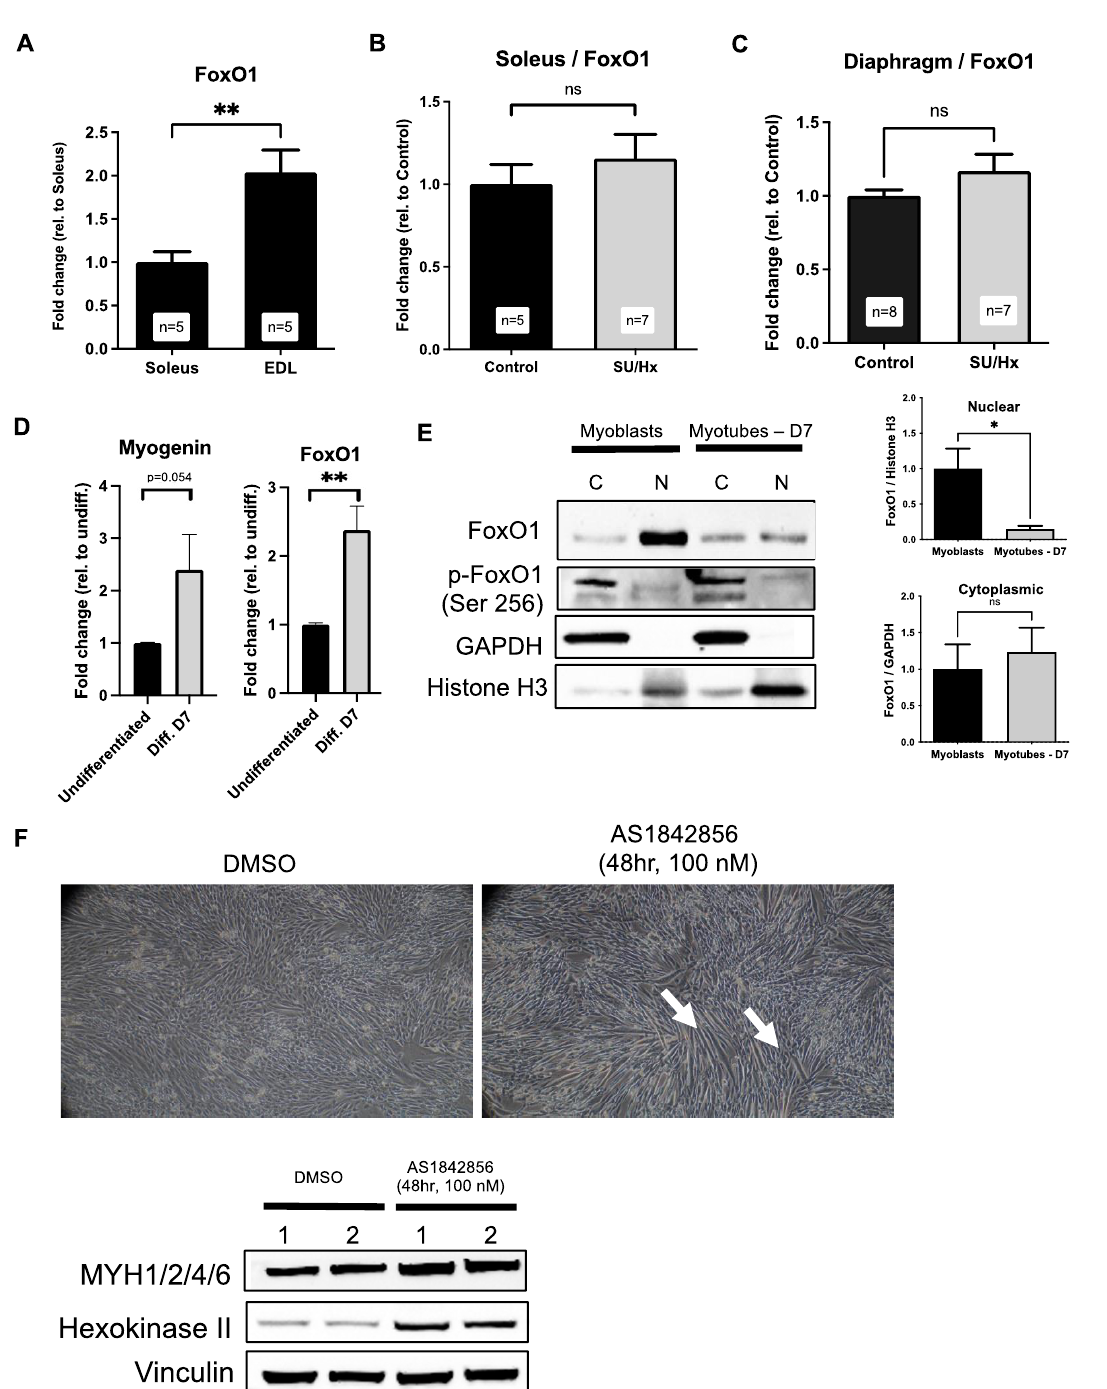
Figure 6. ( A ) There is an increased expression of FoxO1 mRNA in the EDL (fast twitch) when this is compared to the soleus (slow twitch) from the control animals. ( B ) A trend for the upregulation of FoxO1 mRNA in soleus of SU/Hx-induced PH is compared to that of the control animals. ( C ) A trend for the upregulation of FoxO1 mRNA in diaphragm of SU/Hx-induced PH is compared to that of the control animals. Expression is normalized to Nup 133 . Values are expressed as the mean ± SEM. Statistical analysis is conducted by a Student’s t -test, ** p < 0.01, ns: not significant. ( D ) There is an increased expression of myogenin and FoxO1 mRNA in the whole cell lysates from differentiated L6 cells (Day 7) when this is compared to the whole cell lysates from undifferentiated cells. Expression is normalized to GAPDH . Values are expressed as the mean ± SEM. Statistical analysis was